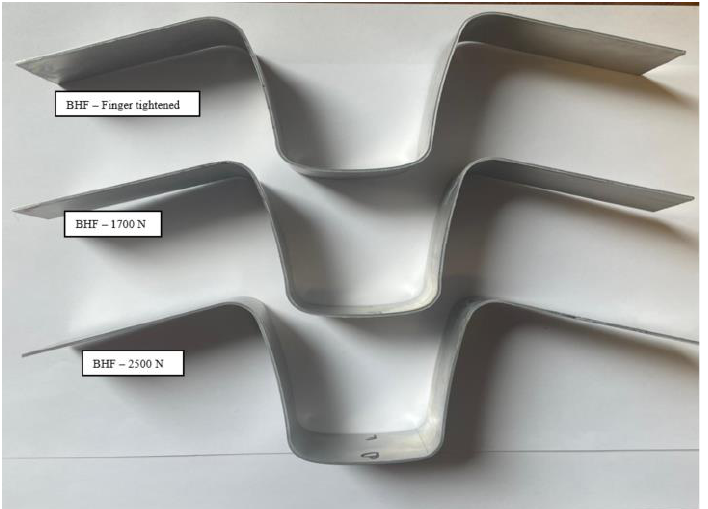
Figure 25. Profiles of Al/PP/Al specimens with 0.2/0.8/0.2 mm thickness combination after spring-